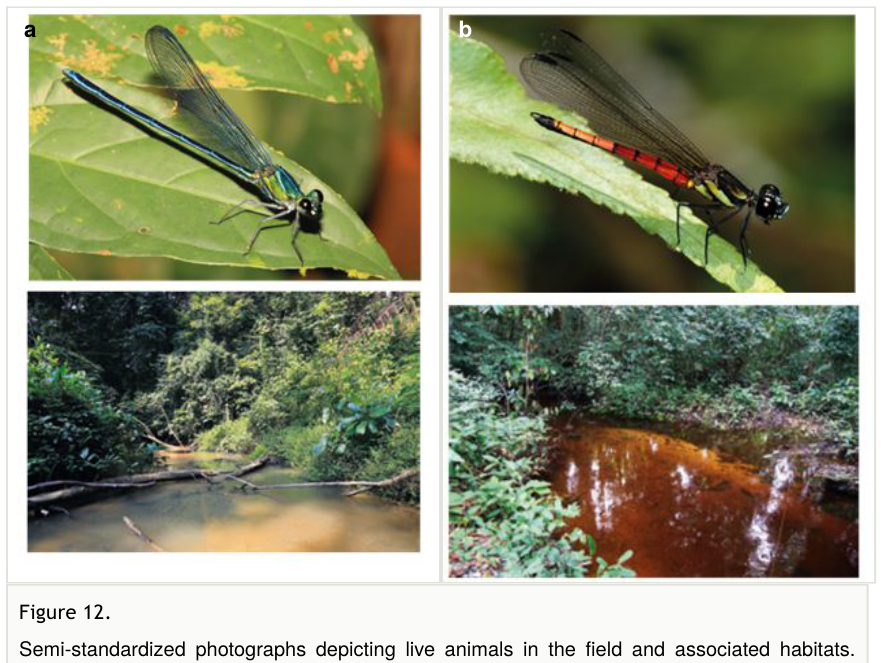
Semi-standardized photographs depicting live animals in the fi eld and associated habitats. From Dijkstra et al.